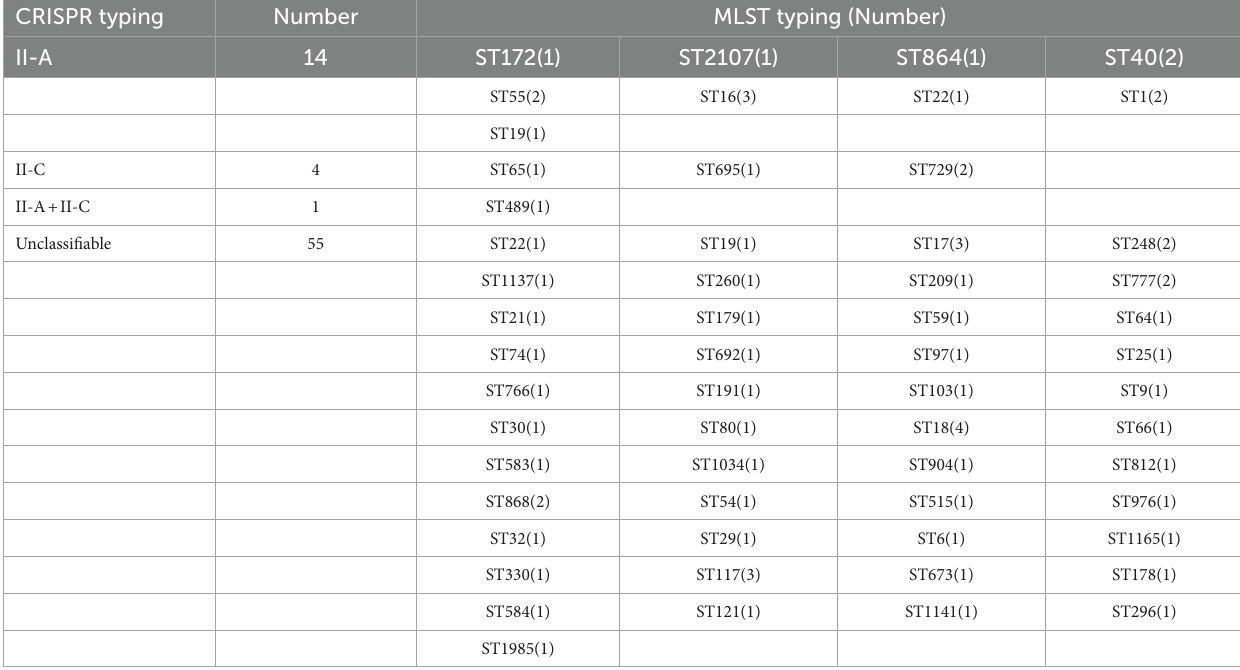
TABLE 3 The relationship between the CRISPR typing and MLST typing. CRISPR